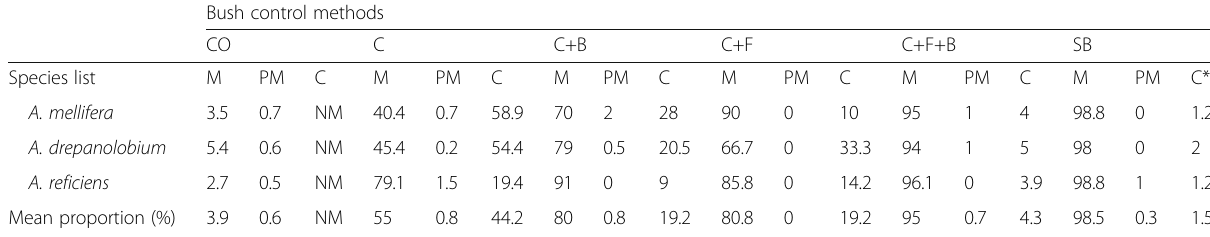
Table 1 Response percentages of individual woody species in terms of complete mortality (M), partial mortality (PM) and coppicing (C) for six bush control treatments in the Borana rangelands